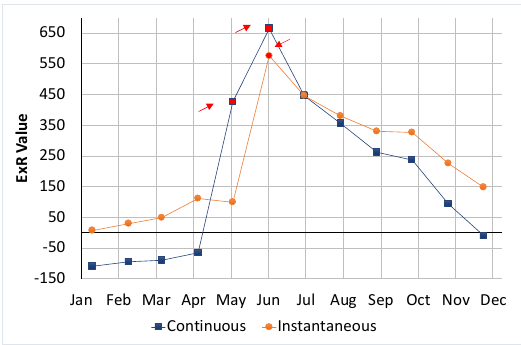
Figure 6. Comparison between an instantaneous and a continuous operation in Serra dos Candeeiros during 2017. Operation dates highlighted in red squares and arrows.